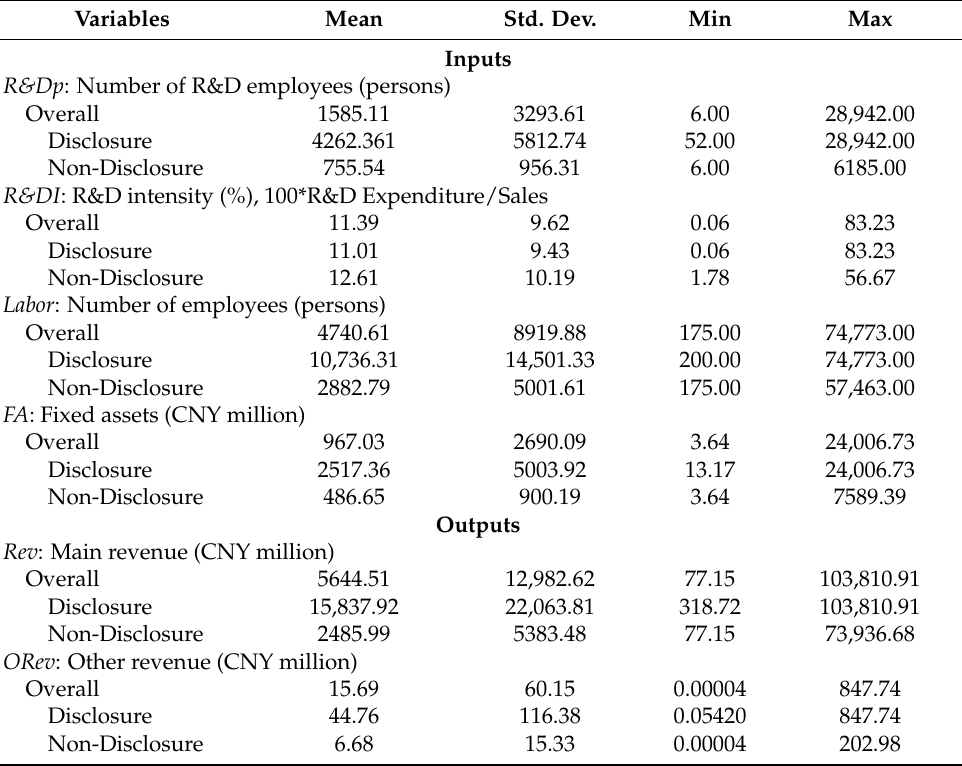
Table 1. Descriptive Statistics of Inputs and Outputs.